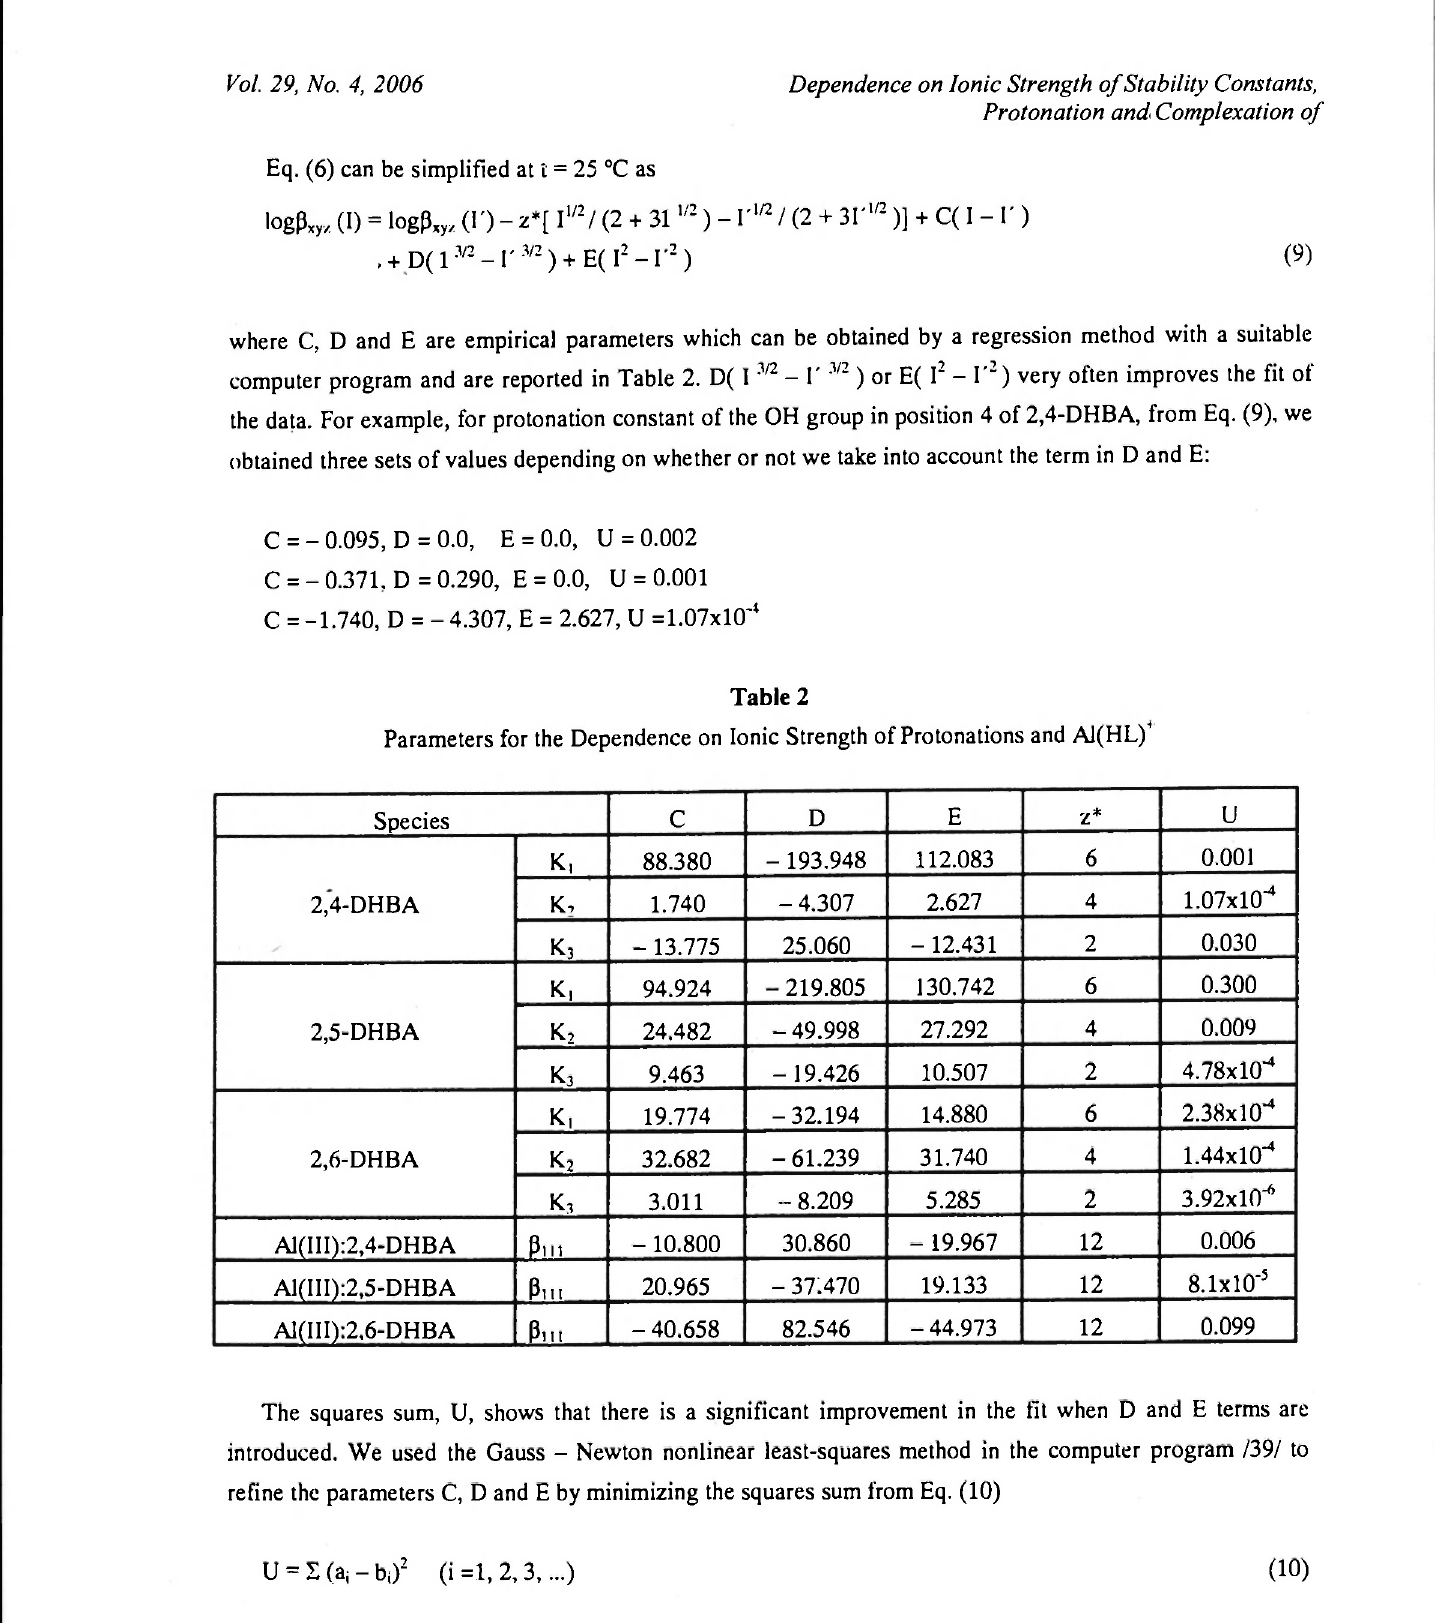
Parameters for the Dependence on Ionic Strength of Protonations and